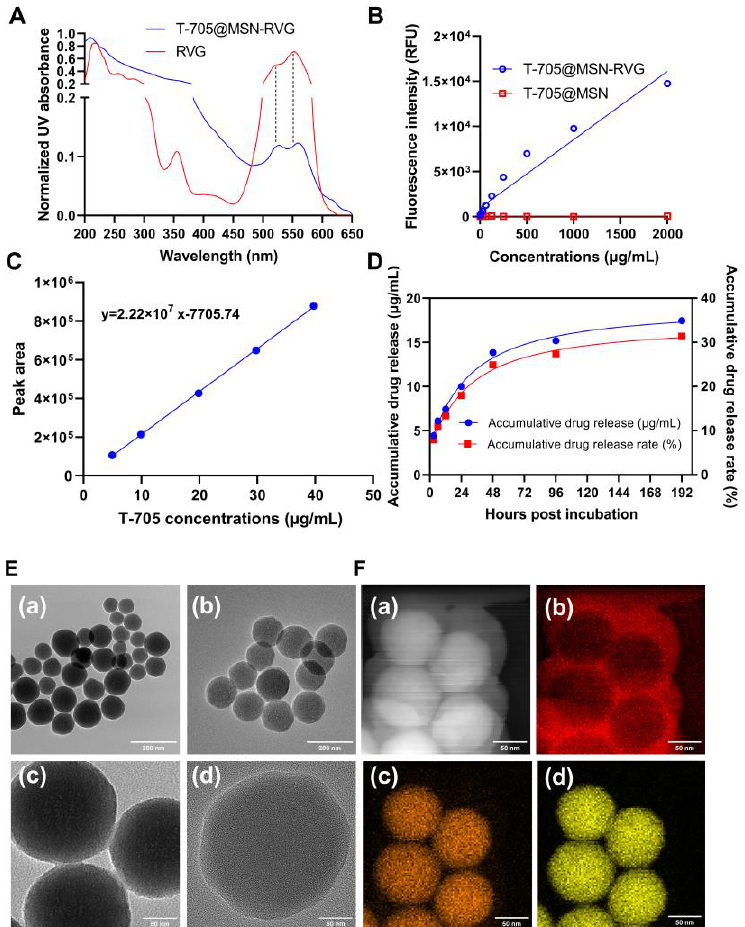
Figure 2. Characterization and drug release profile analysis of T-705@MSN-RVG. ( A ) The ultraviolet (UV) spectrums of RVG and T-705@MSN-RVG were determined at 200 to 650 nm wavelengths. ( B ) The serially diluted T-705@MSN-RVG and T-705@MSN at concentrations of 1.95 to 2000 μg/mL were tested to investigate the fluorescence intensities of Cy3. ( C ) The favipiravir was serially diluted at concentrations of 40, 30, 20, 10, and 5 μg/mL to be detected to calculate the standard curve. ( D ) To investigate the drug release curve, 2 mg of T-705@MSN-RVG was diluted in 5 mL of release buffer to be detected at 3, 6, 12, 24, 48, 96, and 192 h, respectively. ( E ) The TEM images of MSN (panel ( a ), scale bar 200 nm; panel ( c ), scale bar 50 nm) and T-705@MSN-RVG (panel ( b ), scale bar 200 nm; panel ( d ), scale bar 50 nm). ( F ) Elemental mapping of T-705@MSN-RVG, scale bar 50 nm. Panel ( a ) presented the bright field. The elements of carbon, oxygen, and silicon were exhibited in panels ( b – d ).